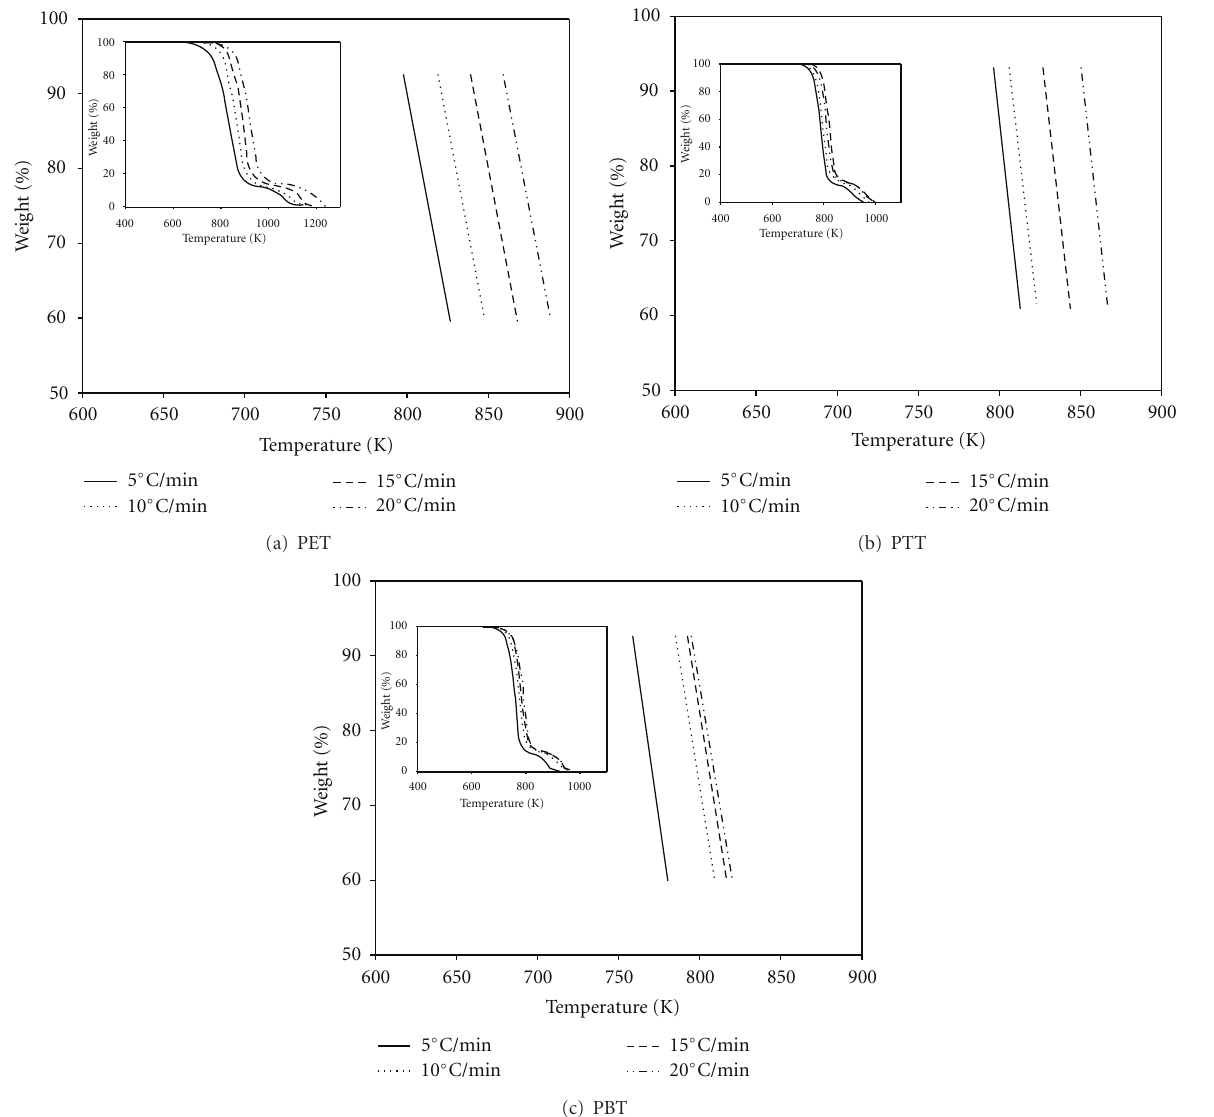
Figure 2: Plot of weight loss (8–40% conversion range) as a function of temperature for polyester degradation in N 2 atmosphere (zone 2).